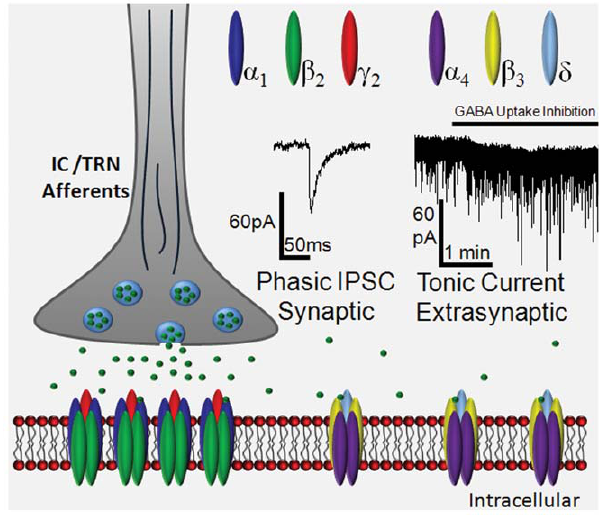
Figure 3. Summary Illustration of GABA A Rs on MGB Neurons: Note receptor location relative to the presynaptic GABAergic terminal (IC or TRN) with classic a 1 c -subunit containing GABA A Rs located within the synapse and a 4 d -subunit containing GABA A Rs outside of the synapse. The concentration of GABA to which each receptor type is typically exposed and the nature of the current mediated by each subtype of receptor is also depicted. For sample traces, the internal solution used here is CsCl-based (140 mM) and the membrane potential is clamped at 2 60 mV. As a result, GABA A R currents are inward and blocked by gabazine. The phasic response (left trace) is expanded from within the trace of the tonic response (right trace). The inward shift in baseline current is induced by upregulating extracellular GABA through inhibition of GABA uptake via the application of neuronal and glial GABA transporters with NNC-711 and SNAP 5114, respectively (solid line, right trace). These sample recordings were obtained from an MGB neuron of a 7-month-old FBN